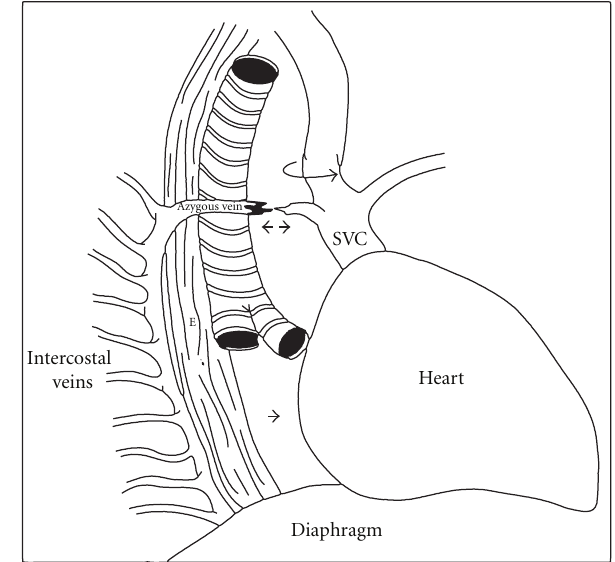
Figure 3: Schematic diagram illustrating the anterior and posterior attachments of the azygous vein (reproduced with permission from Annals of Thoracic